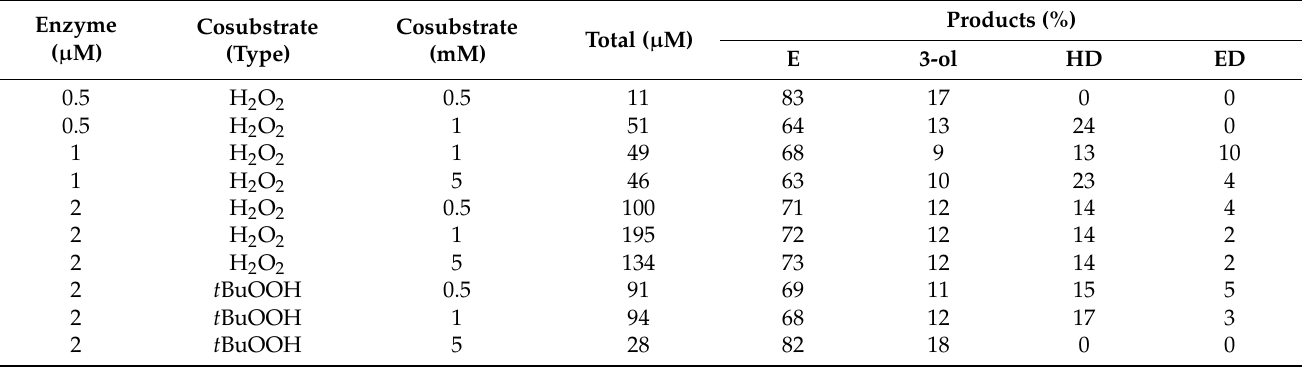
Table 1. Total ( µ M) and relative abundance (%) of products (E, 3-ol, HD, and ED, see Scheme 1) from the reactions (24 h, 60% acetone) of 1-tetradecene (1 mM) with several doses of enzyme ( Cgl UPO) and cosubstrates (H 2 O 2 or t